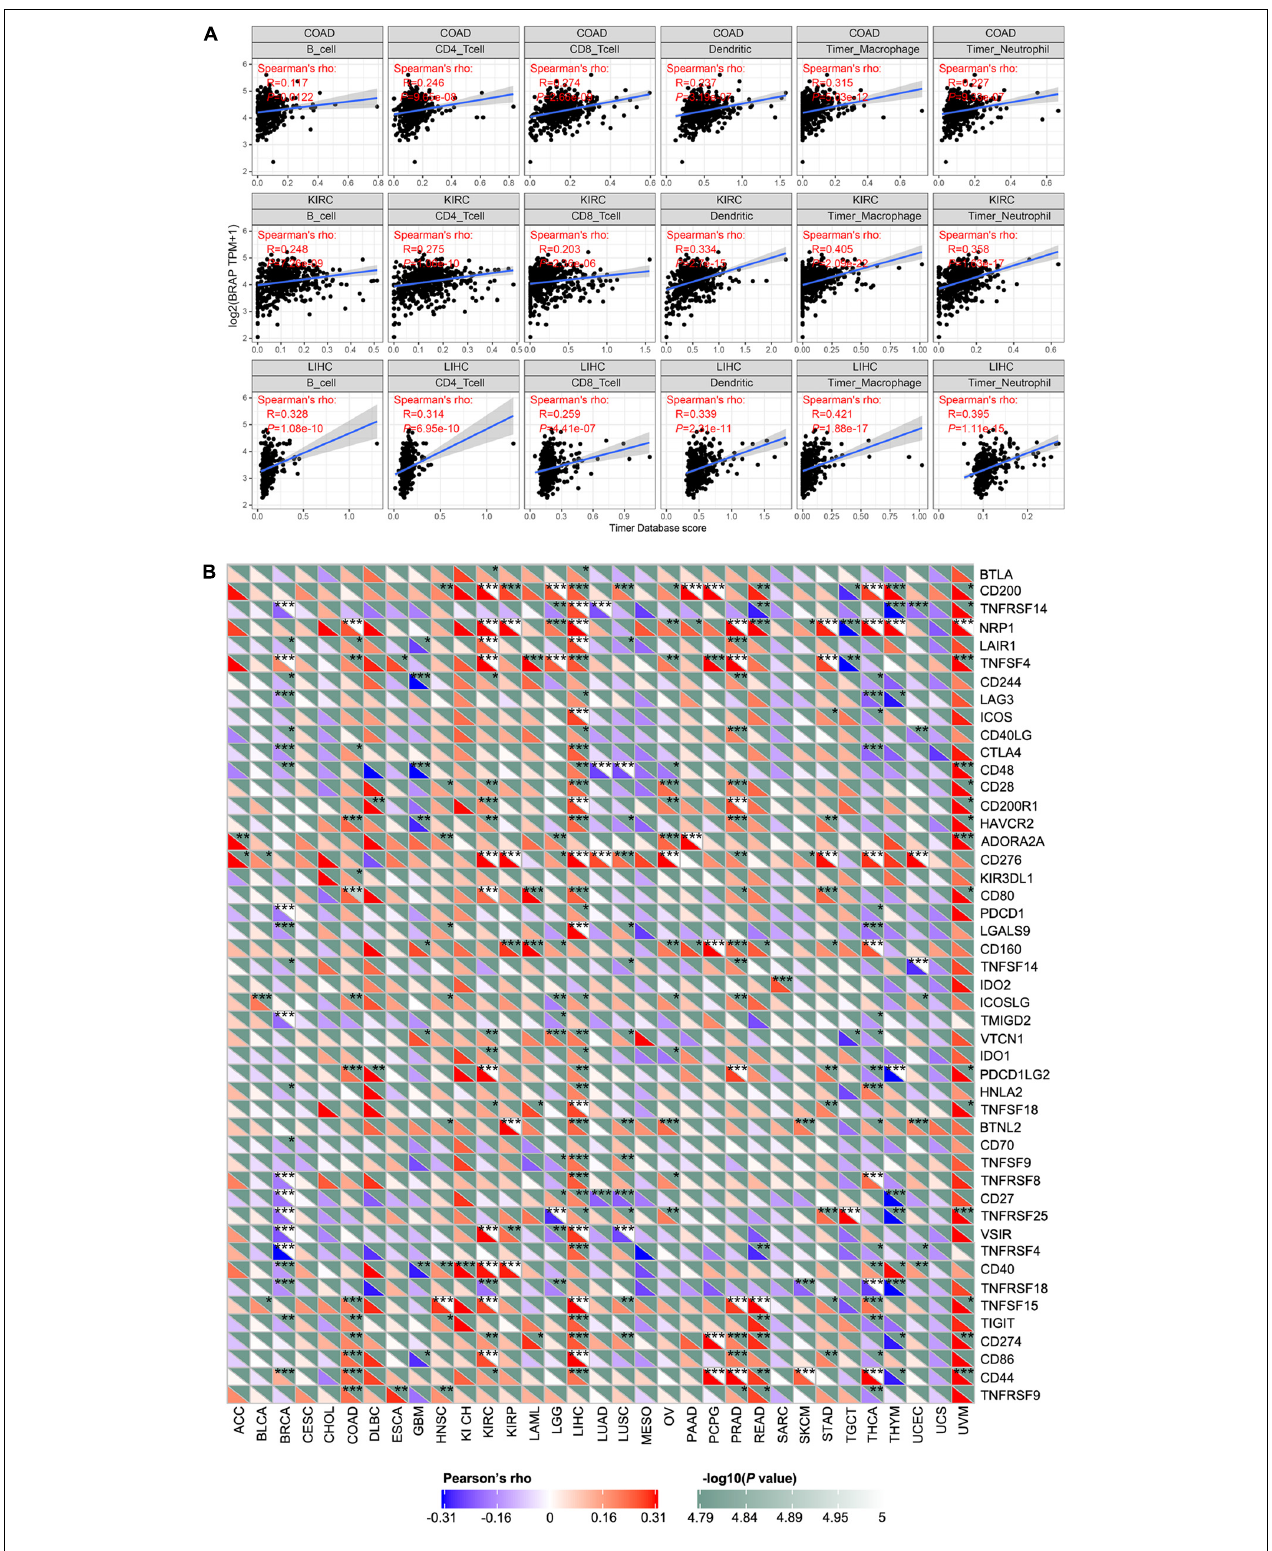
FIGURE 6 | BRAP expression is correlated with immune infiltration and immune checkpoint marker. (A) BRAP expression is positively correlated with immune infiltration in COAD, KIRC, and LIHC. (B) Correlation analysis of BRAP expression level with 40 common immune checkpoint gene levels in human pan-cancer. * P < 0.05, ** P < 0.01, *** P < 0.001.